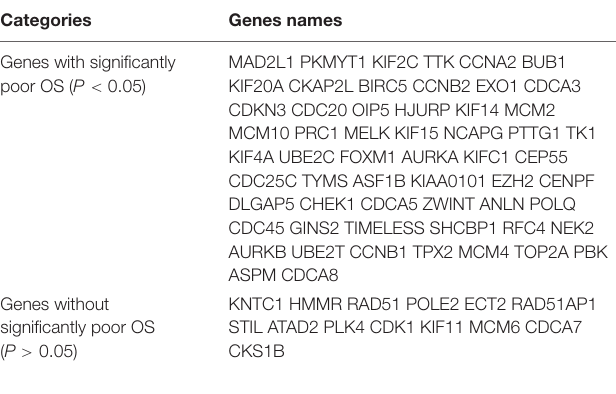
TABLE 2 | The overall survival analysis of the 72 hub